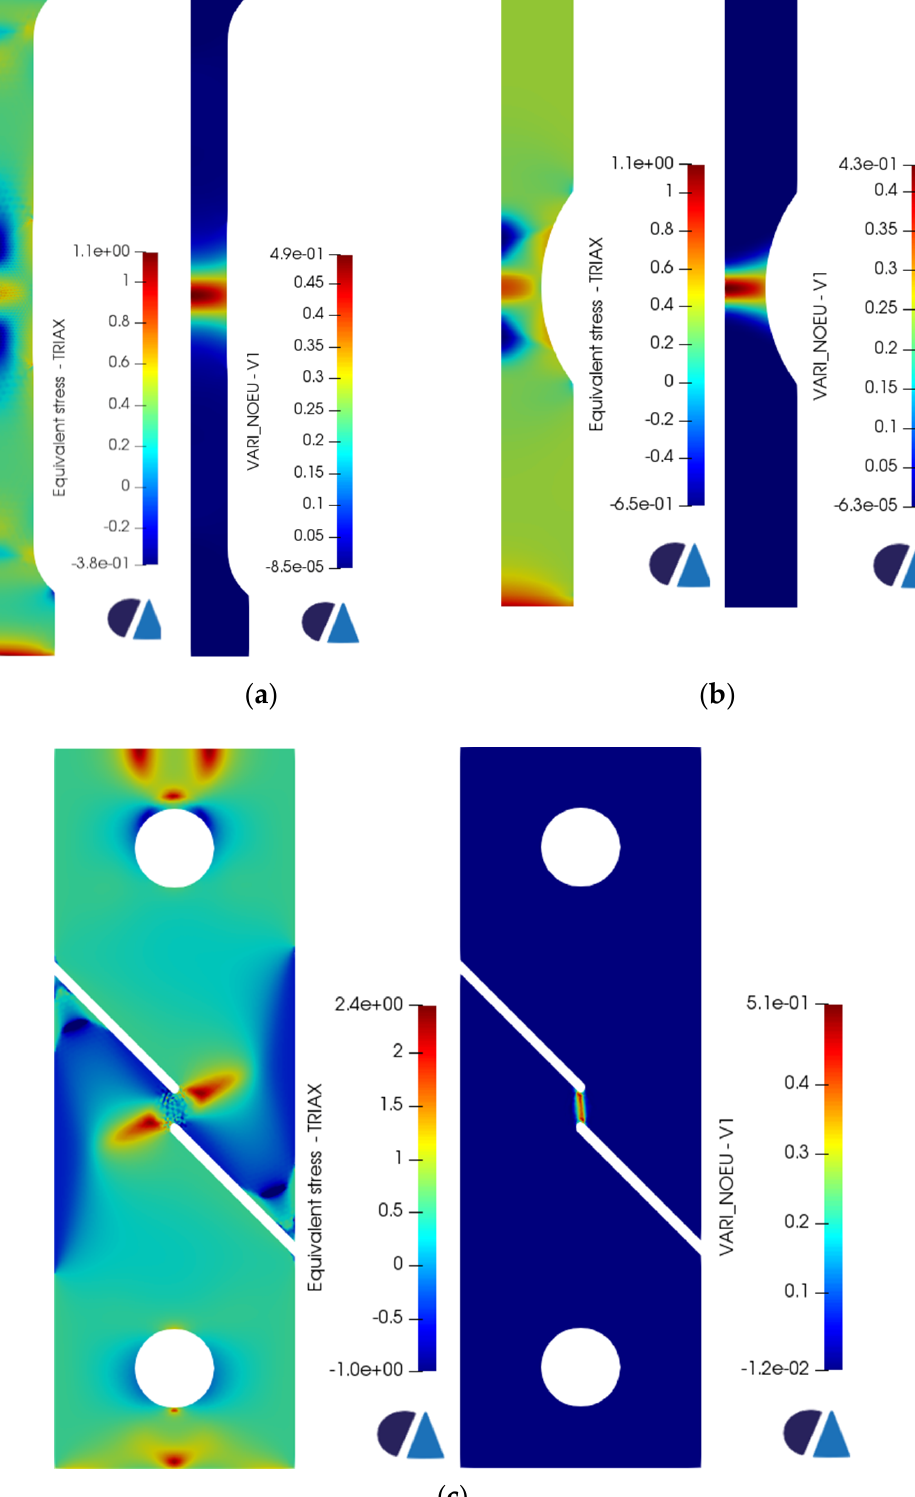
Figure 7. Triaxiality (TRIAX) and Equivalent Plastic Strain (V1) of the ( a ) round bar, ( b ) round notched bar, and ( c ) pure shear sample.